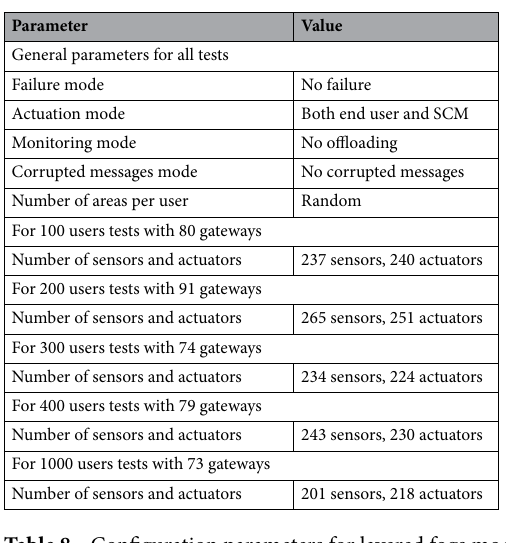
Table 8. Configuration parameters for layered fogs modes.